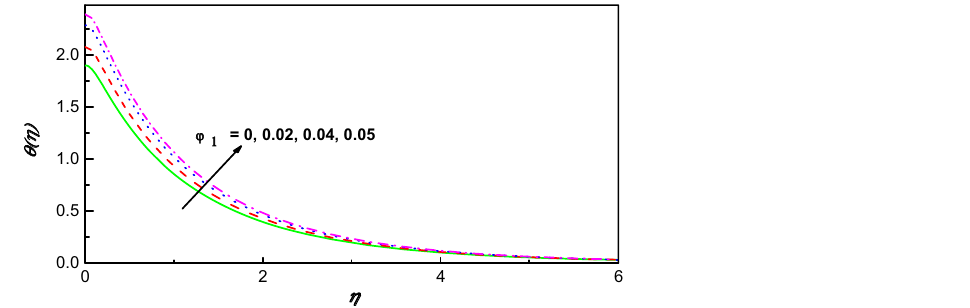
Figure 10. θ(η) variation vs. ϕ 1 .